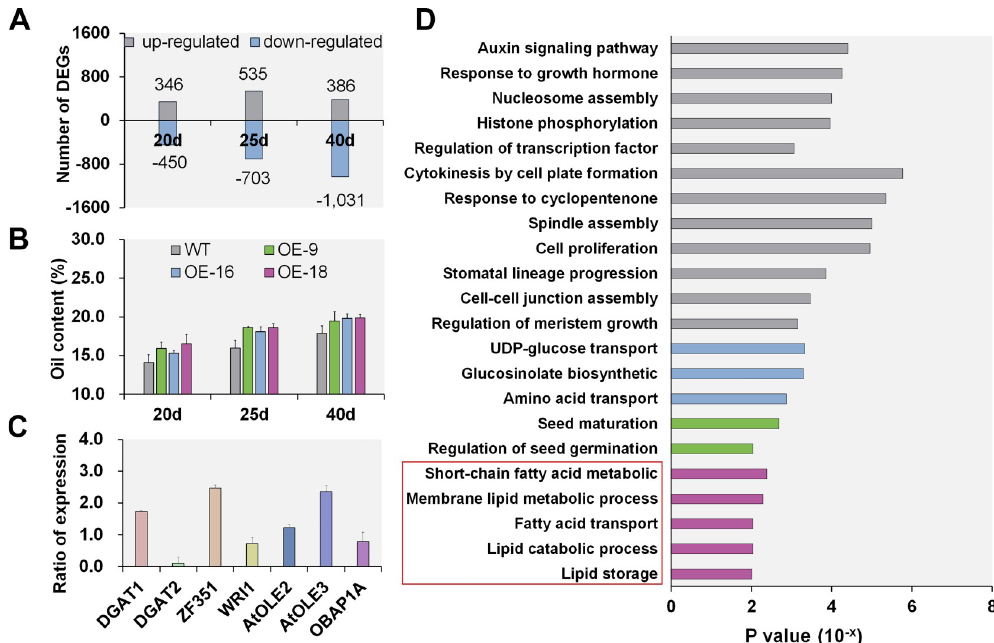
Fig 7. Comparative transcriptomic analysis of developing seeds between the OE lines and WT at different seed development stages. A, Histograms showing the differentially expressed genes (DEGs) in OE seeds relative to WT seeds at 20, 25 and 40 DAF, respectively. B, Comparison of oil content accumulation between the OE and WT seeds at 20, 25 and 40 DAF ( P < 0.01). C, Expression analysis of the putative genes involved in plant oil biosynthesis in OE-9 seeds at 40 DAF. Error bars are SD. The Y-axis represents the ratio of expression of a gene in the OE lines relative to WT, D, GO enrichment analysis for the DEGs between the OE and WT seeds at 40 DAF. Purple, green, and blue columns represent the enriched GO terms associated with oil metabolism pathway, seed germination, and protein metabolism pathway,